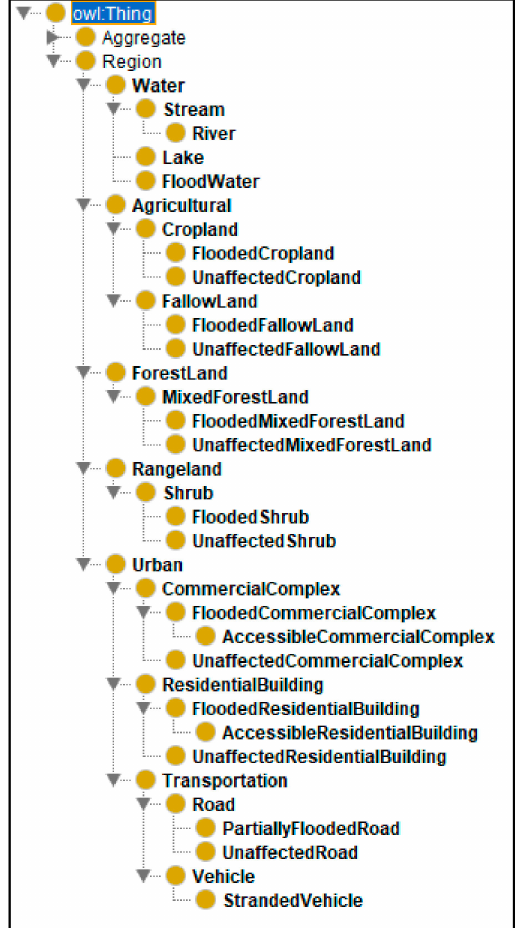
Figure 10. Snapshot of the Classes Hierarchy of the Flood Scene Ontology (FSO) that extends the Remote Sensing Scene Ontology